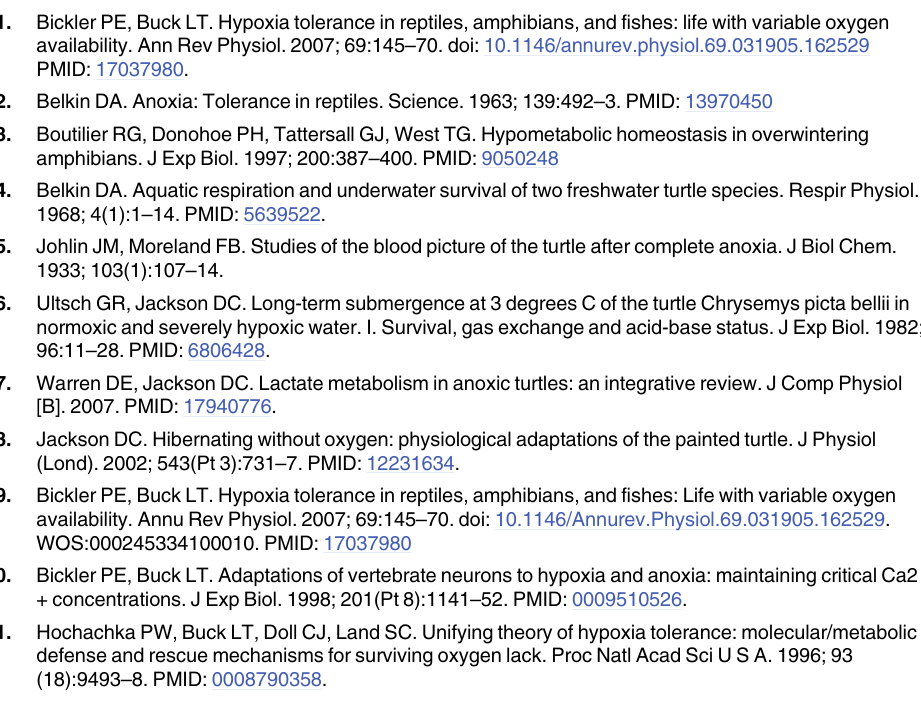
S6 Table. Gene Ontology (GO) process-based outputs from genes that were significantly increased across tissues (treatment only effects) in anoxic painted turtles. S7 Table. Gene Ontology (GO) function-based outputs from genes that were significantly increased in telencephalon of anoxic painted turtles. S8 Table. Gene Ontology (GO) function-based outputs from genes that were significantly increased in ventricle of anoxic painted turtles. S9 Table. Gene Ontology (GO) function-based outputs from genes that were significantly increased across tissues (treatment only effects) in anoxic painted